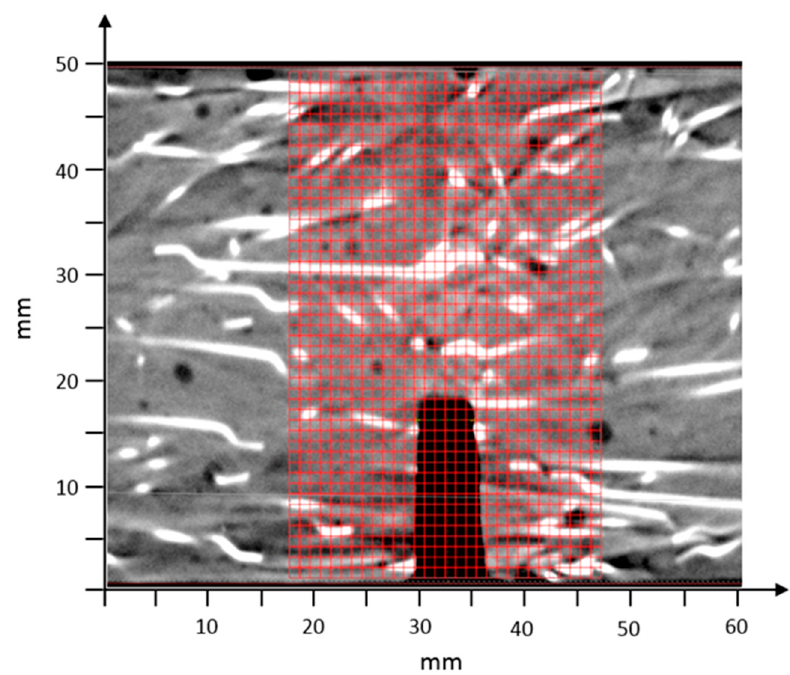
Figure 1. Section of beam computed tomography (CT) image with overlaid finite element mesh.